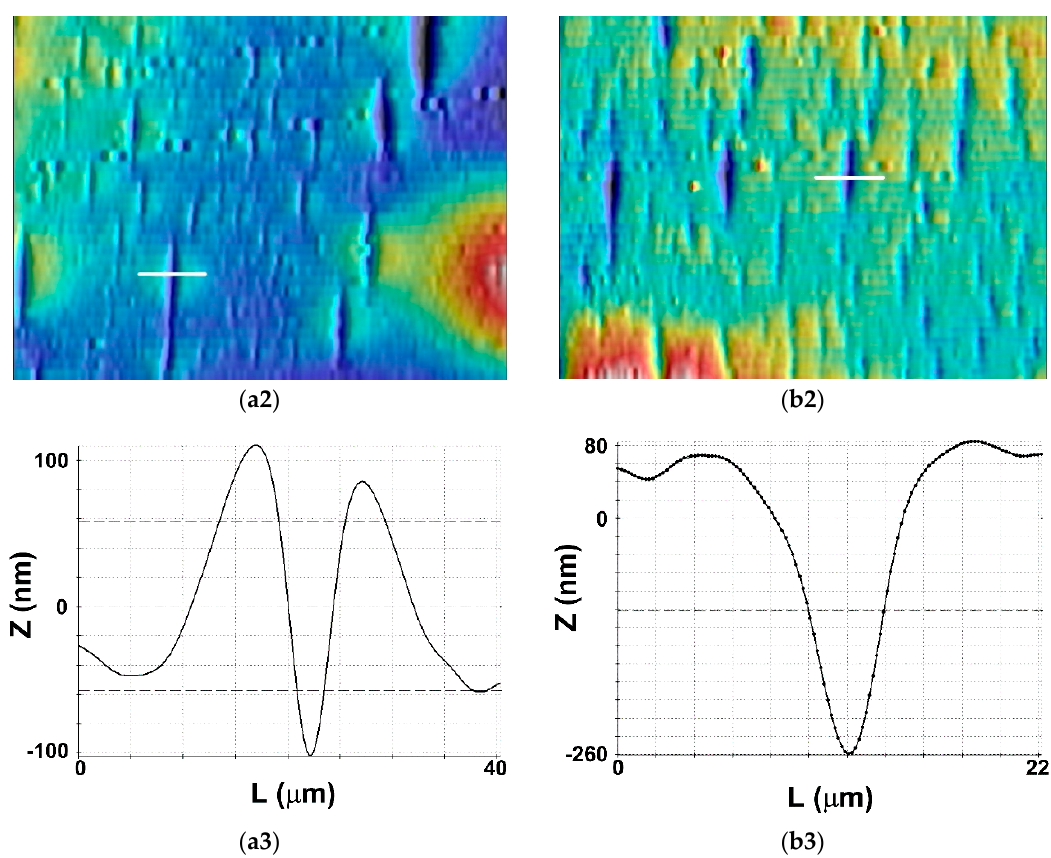
Figure 18. Typical surface morphology within necked area for samples programmed at 128 °C. Top row (1): 3D view; middle row (2): top view (area: 140 × 100 μ m); bottom row (3) cross-section of the crack marked in middle row (2). Left: 30% strained; right: 100% strained.